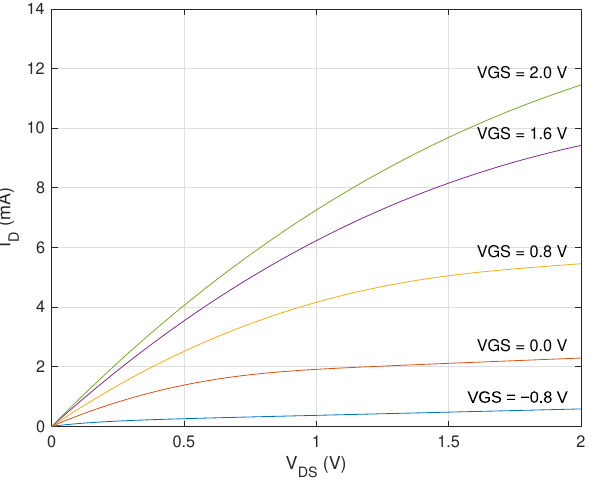
Figure 2. MoS 2 -FET model: ( a ) model parameter values used for the basic power transistor; ( b ) out- put characteristics.